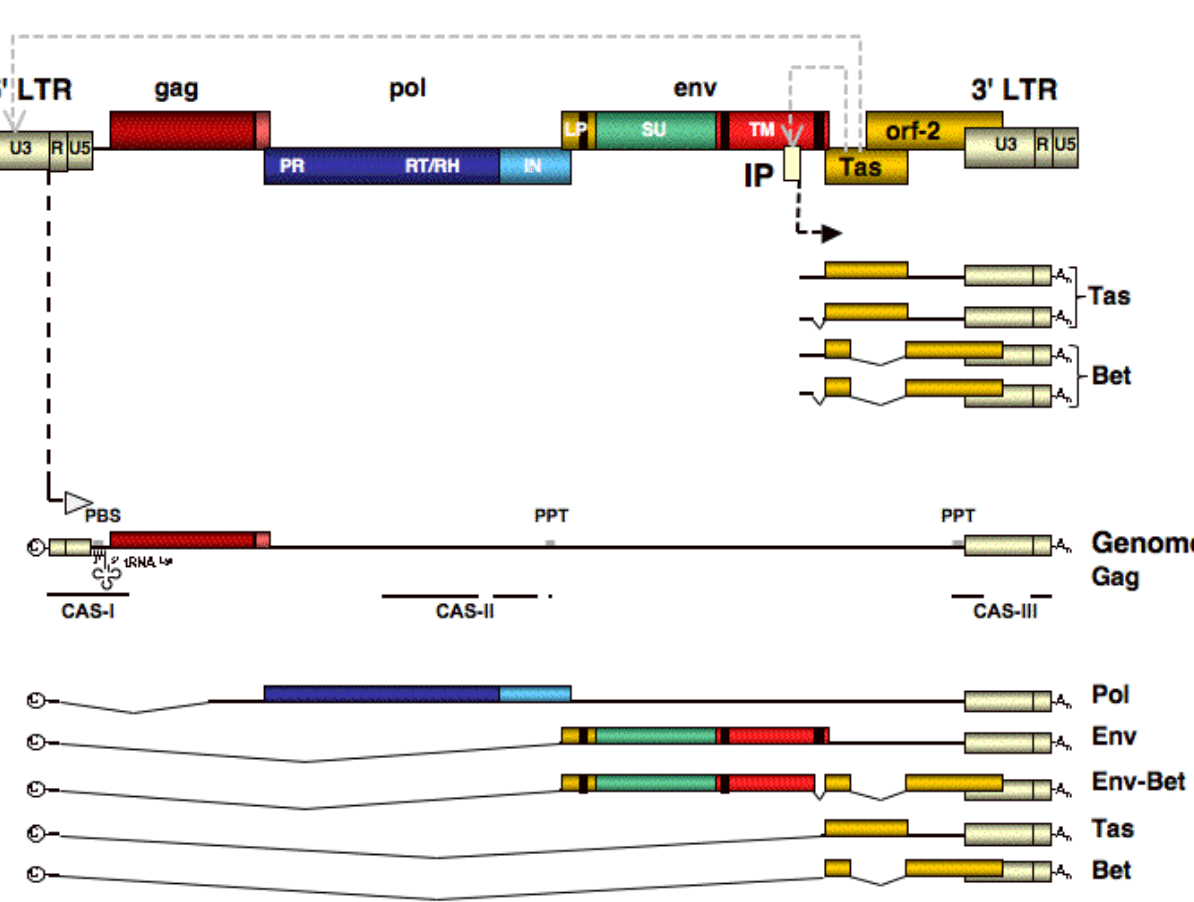
Figure 2. Spuma- or foamy viruses (FV) RNA and DNA genomic organization. Schematic outline of the FV proviral genome (top) and the genomic (middle) and subgenomic transcripts generated by cellular RNA polymerase from long terminal repeat (LTR) and internal promoter (IP). c: cap structure; An: poly-alanine; CAS: cis -acting